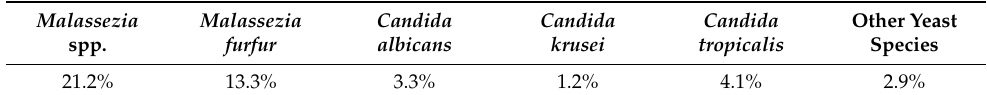
Table 1. The frequencies of tested microbial causative-agents among people who have